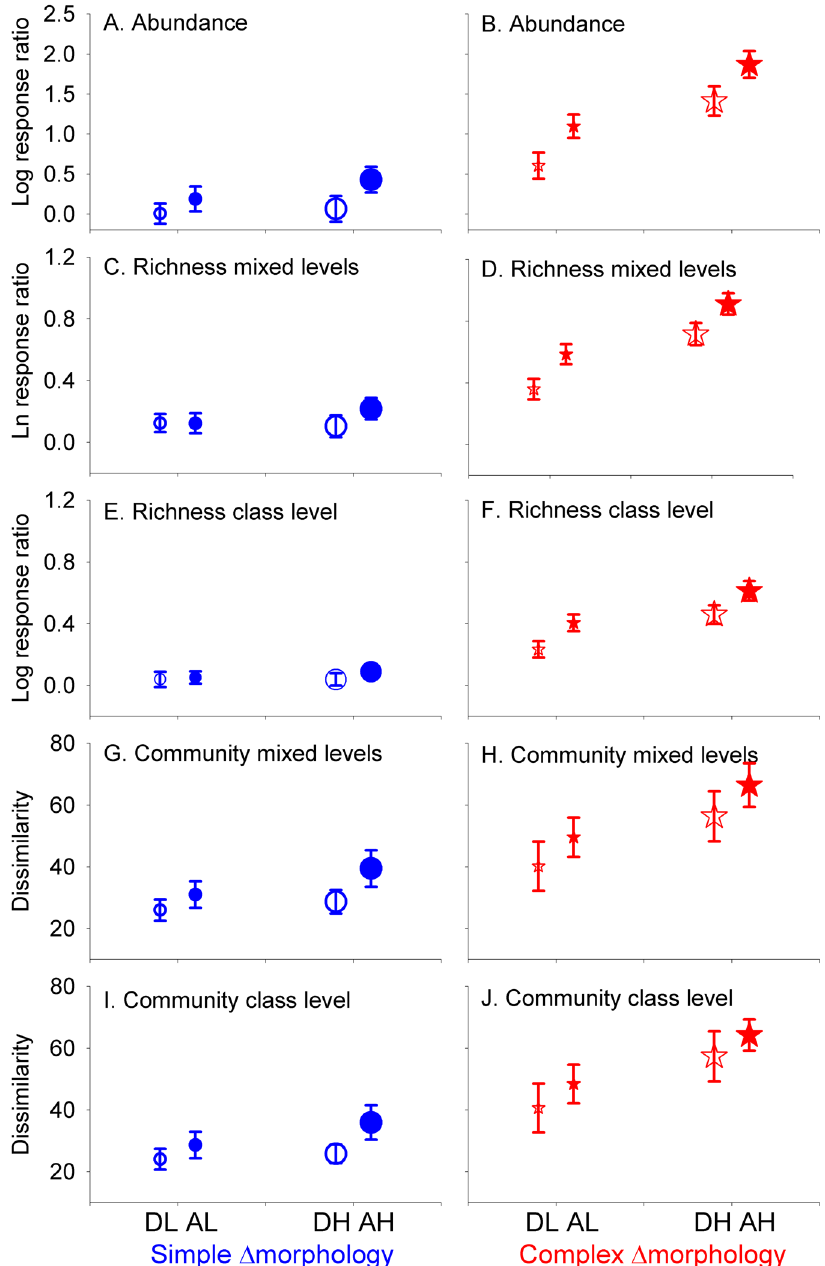
Fig. 2 Effects of habitat heterogeneity on biodiversity from 22 geographically distributed facilitation experiments. Effects of three orthogonal axes of habitat heterogeneity (Amount, Function, Δ Morphology) in 22 facilitation cascade experiments measured on animal abundances ( A , B ), taxonomic richness on mixed ( C , D ) and class ( E , F ) level, and Bray – Curtis community dissimilarity on mixed ( G , H ) and class ( I , J ) level. Data are presented as mean values ± 95% con fi dence limits. Log response ratios were calculated by comparing treatments where primary and secondary foundation species (FS) co- occur to controls where the primary FS was alone so that values above zero imply that the secondary FS increases biodiversity. Log response ratios were calculated from individual samples for abundance and richness (replication levels from left = 80, 75, 73, 78, 132, 135, 134, 128) whereas community dissimilarities were calculated for each combination of two sites and 11 experiments per Δ morphology (i.e. replication level = 22). Blue circles vs. red stars = Low vs. High Δ Morphology; small vs. large symbols = Low vs. High Amount; open vs. closed symbols = Low vs. High Functionality. Legend Text on fi gure: DL = Dead-Low amount, AL = Alive-Low amount, DH = Dead-High amount, AH = Alive-High amount. Data underpinning the fi gure are provided as online Source Data fi